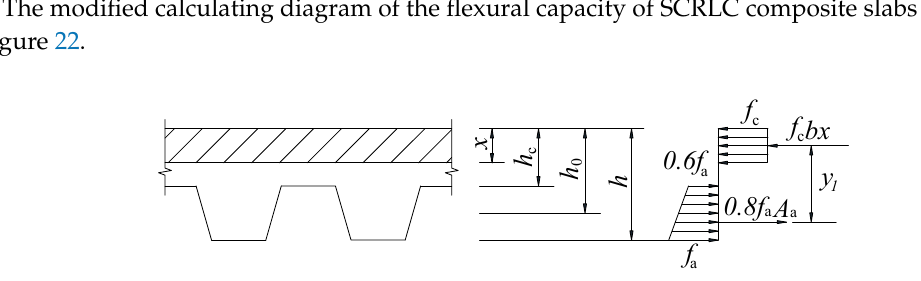
Figure 22. Modified calculating diagram of flexural capacity of composite slabs.